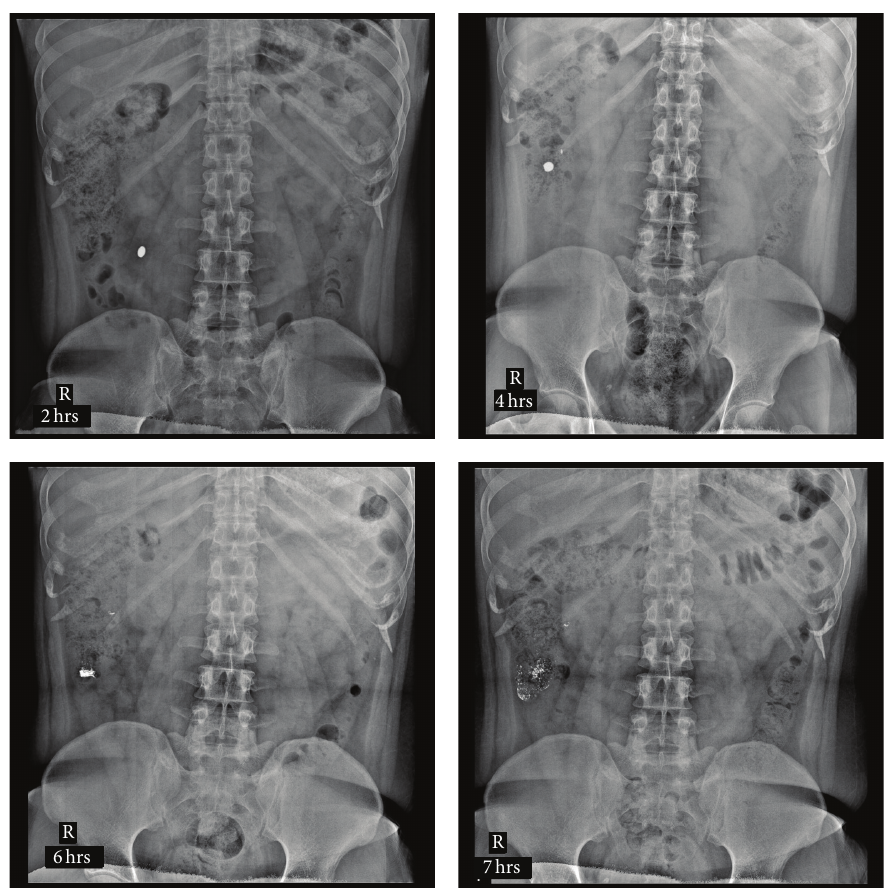
Figure 5: X-ray slides showing compressed coated tablet at different time interval in healthy human